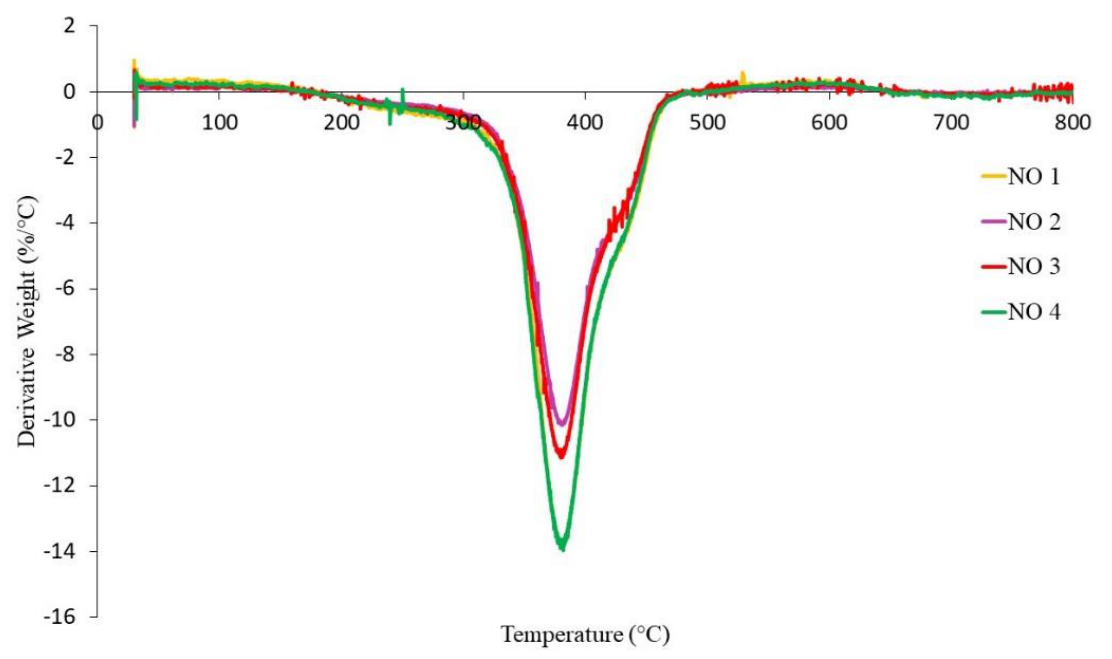
Figure 13. DTG curves of NR-based MREs for different ratios of NO:AO.